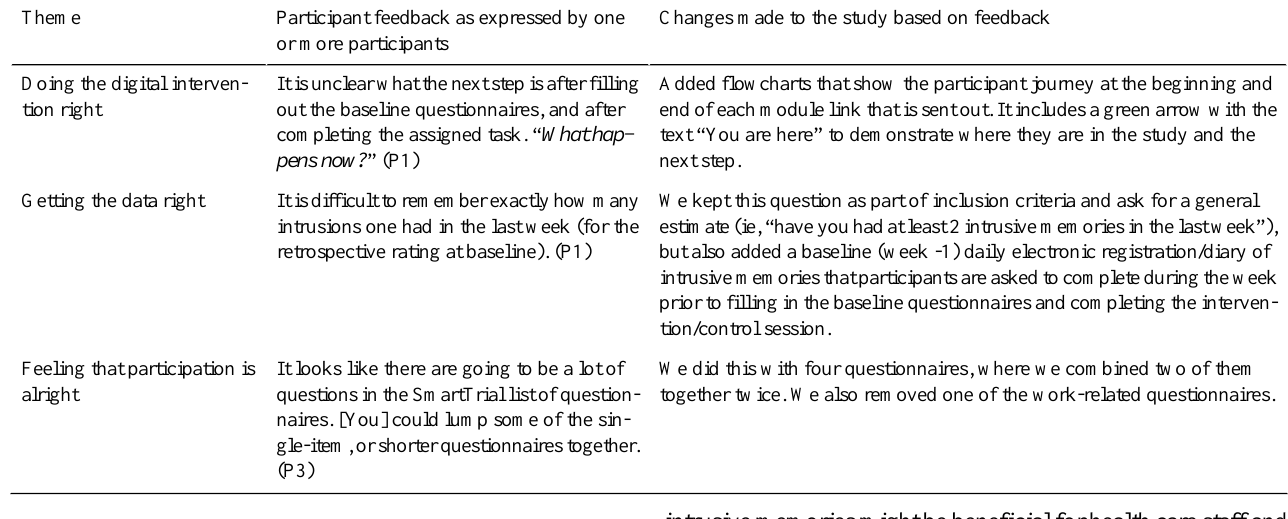
Table 3. Examples of changes made to study materials and procedure following participant feedback [54].